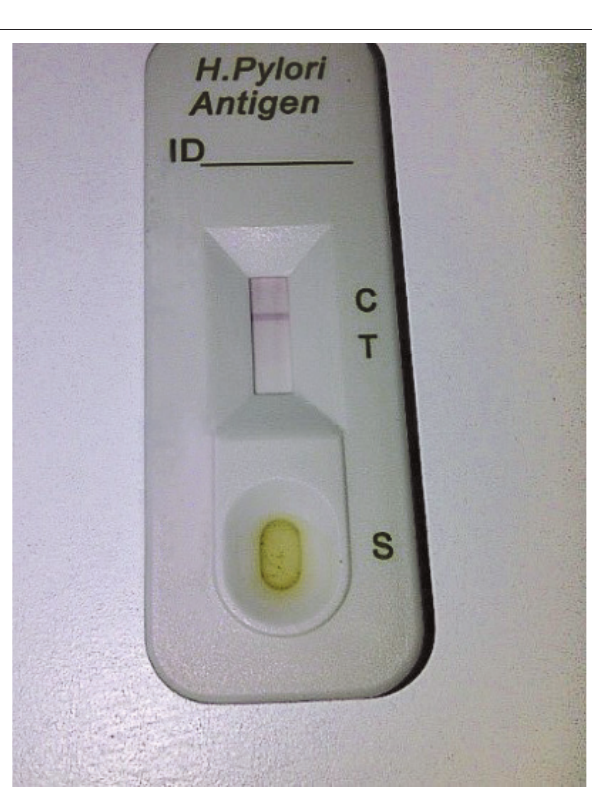
FIGURE 3: Helicobacter pylori growth un-inhibited by tetracycline, metronidazole or cefuroxime.